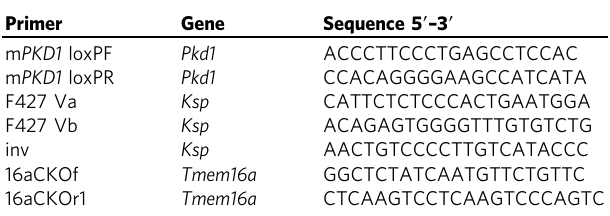
Table 1 Primers used for genotyping.